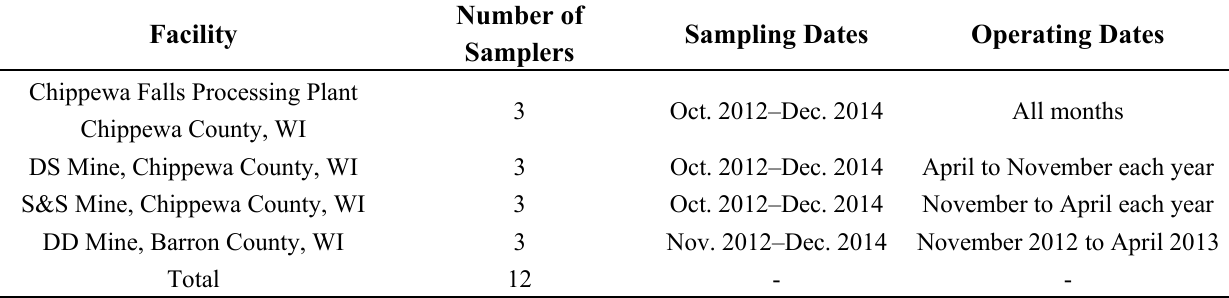
Table 1. Facilities conducting ambient respirable crystalline silica sampling in